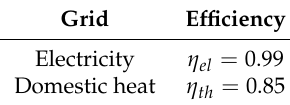
Table 7. Transmission efficiencies of the energy